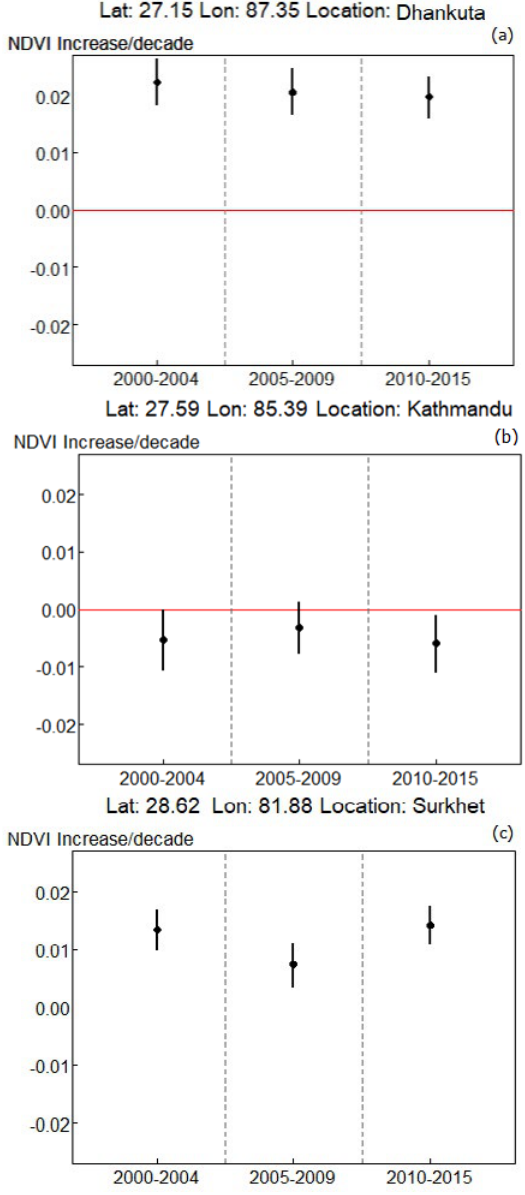
Fig. 5. A 95% CI plot of NDVI temporal change in Dhankuta (a), Kathmandu (b) and Surkhet (c)